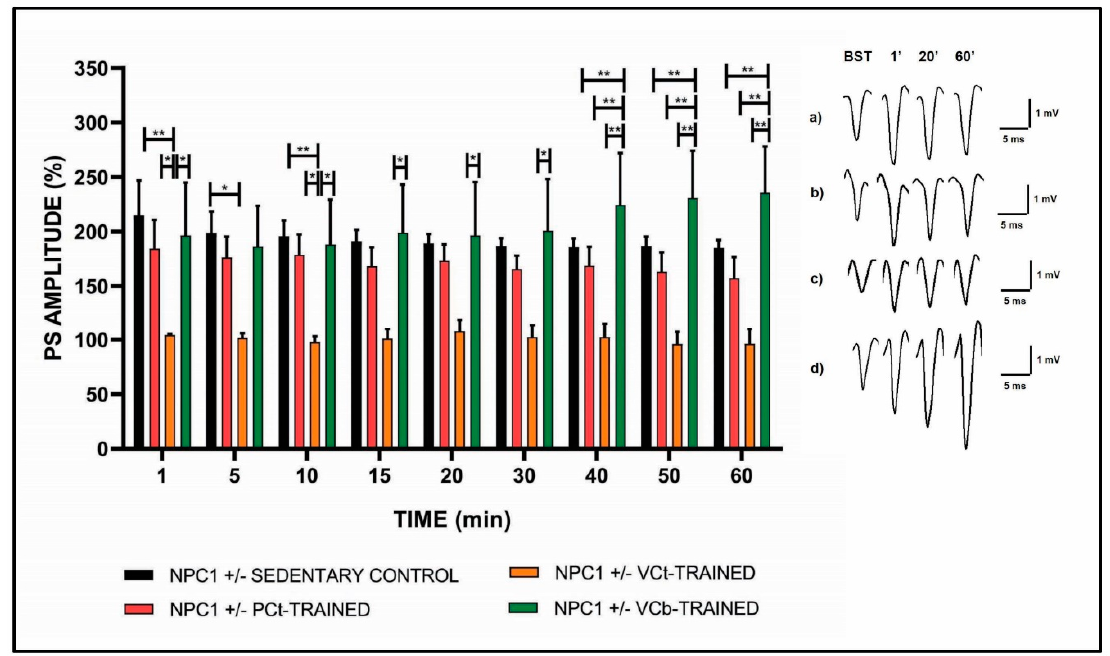
Figure 2. Synaptic plasticity in CA1 hippocampal subfield of NPC1 +/ − mice. The % PS amplitude after tetanic stimulation (HFS) as a function of time is shown in NPC1 +/ − SEDENTARY CONTROL (black bar, n = 5), in NPC1 +/ − PCt-TRAINED (pink bar, n = 5), in NPC1 +/ − VCt-TRAINED (yellow bar, n = 4) and in NPC1 +/ − VCb-TRAINED (green bar, n = 4) mice slices at min 1, 5, 10, 15, 20, 30, 40, 50, 60. Bars in the plot are means ± SEM of values obtained from di ff erent slices. The insert shows recordings obtained from slices of NPC1 +/ − SEDENTARY CONTROL ( a ) NPC1 +/ − PCt-TRAINED ( b ) NPC1 +/ − VCt-trained ( c ) and NPC1 +/ − VCb-trained ( d ) mice. Note that a significant statistical di ff erence was reported between the experimental groups (Min 1: CTRL vs. VCt, ** p < 0.01; PCt vs. VCt and VCt vs. VCb, * p < 0.05. Min 5: CTRL vs. VCt, * p < 0.05. Min 10: CTRL vs. VCt, ** p < 0.01; PCt vs. VCt and VCt vs. VCb, * p < 0.05. Min 15, 20 and 30: VCt vs. VCb, * p < 0.05. Min 40, 50 and 60: CTRL vs. VCb, PCt vs. VCb and VCt vs. VCb, ** p < 0.01). The first curve of each group refers to the